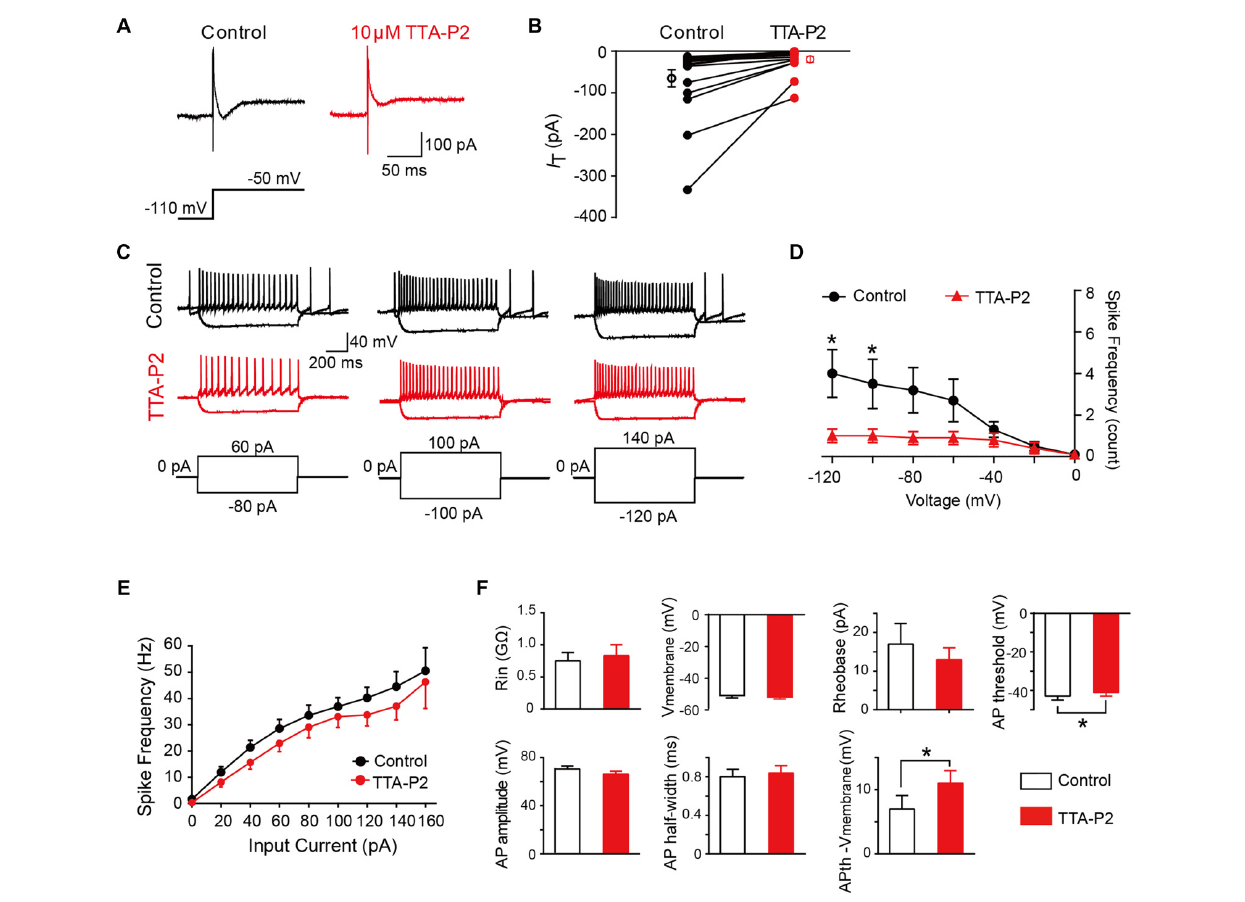
FIGURE 7 | Effect of T-type calcium channel blockers on the intrinsic membrane properties of SG neurons. (A) Representative T-type current traces in response to voltage-clamp protocol shown below traces in the treatment of control (black) and TTA-P2 (red). (B) Population data showing the peak amplitude of T-type currents in the absence (black) and presence of TTA-P2 (red). (C) Examples of depolarizing and hyperpolarizing traces in response to current-clamp protocols shown below traces before (black) and after (red) the treatment of TTA-P2. (D) Population data showing the rebound depolarization-evoked spike frequency plotted as a function of test potentials in the absence (black) and presence of TTA-P2 (red). (E) Population data showing the AP spike frequency plotted as a function of elicited currents in the absence (black) and presence of TTA-P2 (red). (F) Bar plots showing the various intrinsic membrane properties of SG neurons in the treatment of control (black) and TTA-P2 (red). V membrane : membrane potential measured at I hold = 0. ∗ P < 0.05.